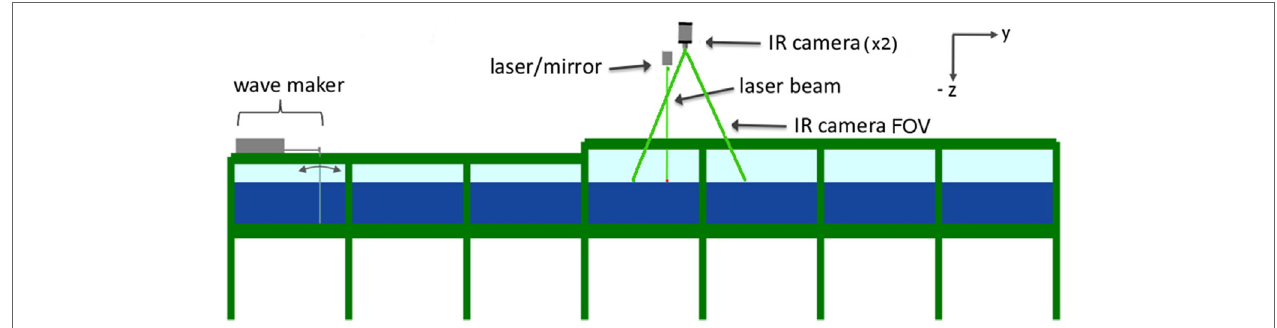
FIgURe 1 | Side-view schematic of the experimental setup. An 8.5 m long and 2.3 m wide tank was filled with 0.5 m of water and equipped with a bottom-hinged wave maker at one end. The laser and both infrared (IR) cameras were located 3.6 m away from the wave maker and 1.9 m above the water level. Across-tank ( x ) distance between the two IR cameras was 1.4 m with both optical axes pointing slightly toward each other and intersecting approximately at the same location on the water surface at the centerline of the wave tank. Along-tank field of view (FOV) of IR cameras is shown with green